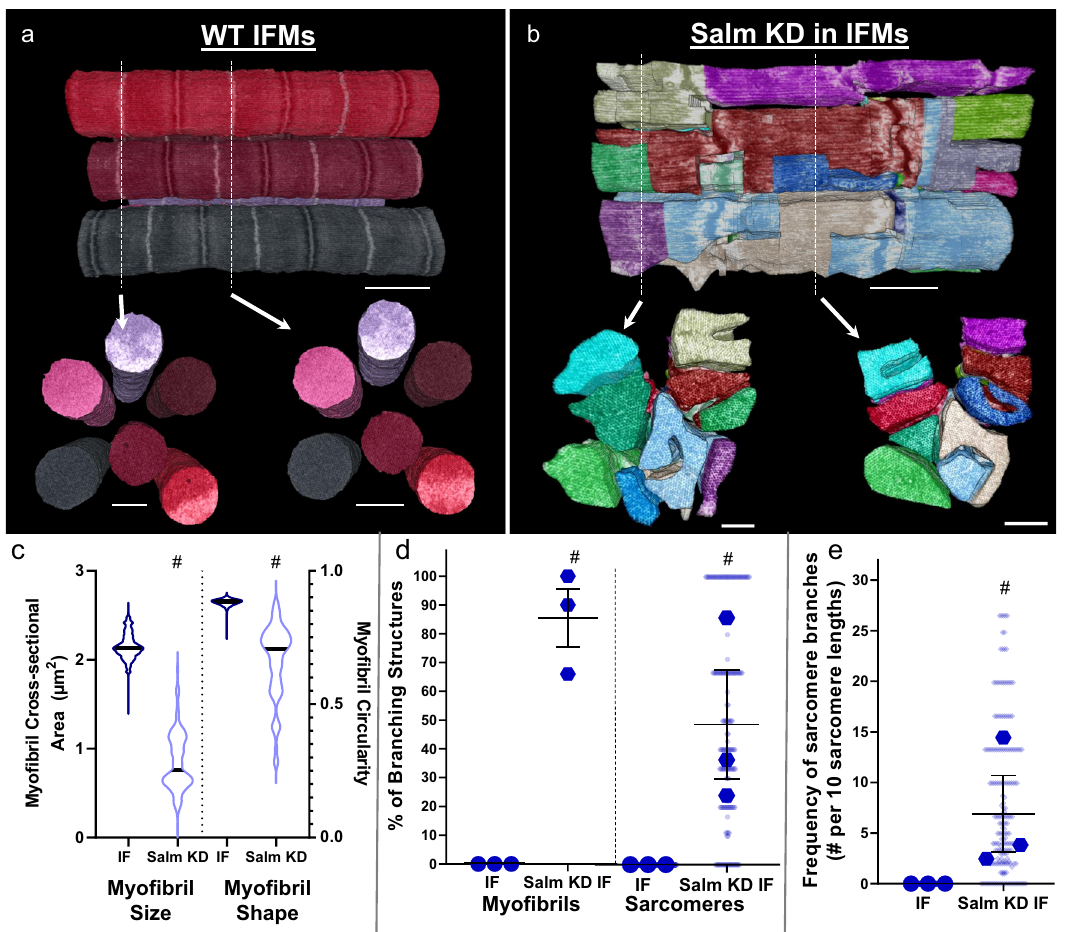
Fig. 3 Loss of salm initiates sarcomere branching through tubular conversion of indirect fl ight muscles. a 3D rendering of myo fi brillar matrix in IF muscles with ( b ) and without ( a ) Mef2-Gal4 driven RNAi knockdown of salm . Bottom two images show clippings through the long axis of the muscle directly above. c Assessment of myo fi bril size and shape for IF and Salm KD IF muscles. d Percentage of myo fi brils with at least one branching sarcomere (left) and percentage of sarcomeres per myo fi bril with a branch (right). e Frequency of sarcomere branching in IF and Salm KD IF muscles. N values:: IF — 3 muscle cells, 3 datasets, 114 myo fi brils, 982 sarcomeres; Salm KD IF — 3 muscle cells, 3 datasets, 180 myo fi brils, 932 sarcomeres. Larger shape symbols represent data from a single cell and smaller shape symbols represent data from a single myo fi bril. Bars represent muscle cell overall mean ± SE. Hash sign (#): Signi fi cantly different from fi brillar IF (two-sided, independent t-test, P < 0.05). Scale bars — 1 μ